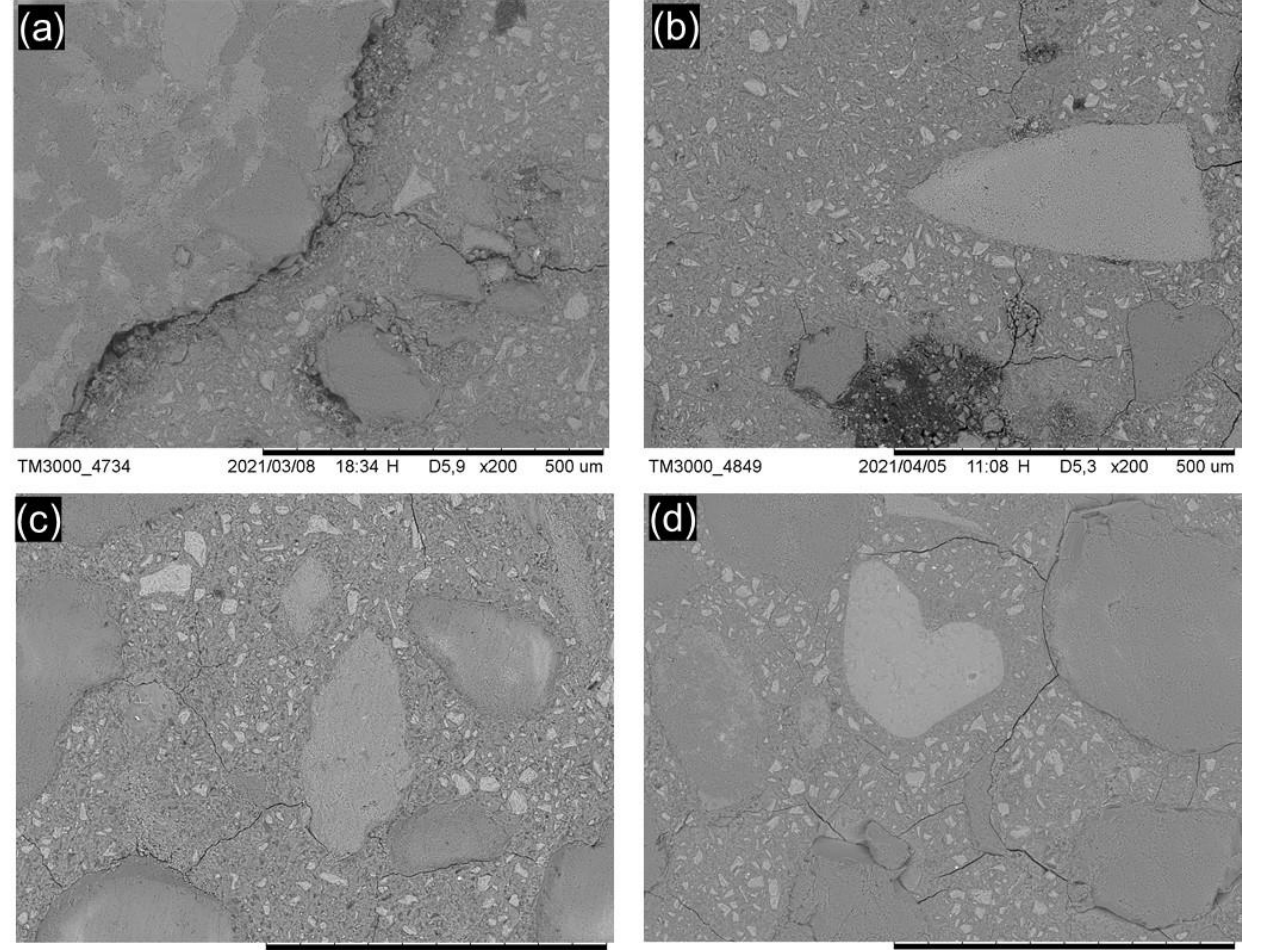
Figure 15. SEM Images ( a ) N4M1, ( b )R4M1.